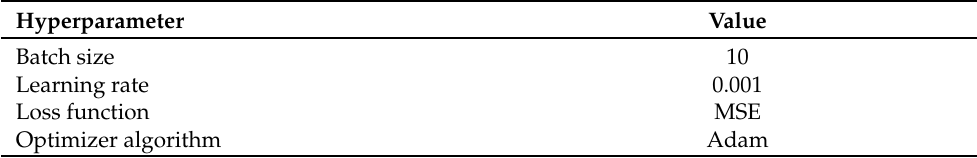
Table 6. Hyperparameters and values used for DAE in the proposed